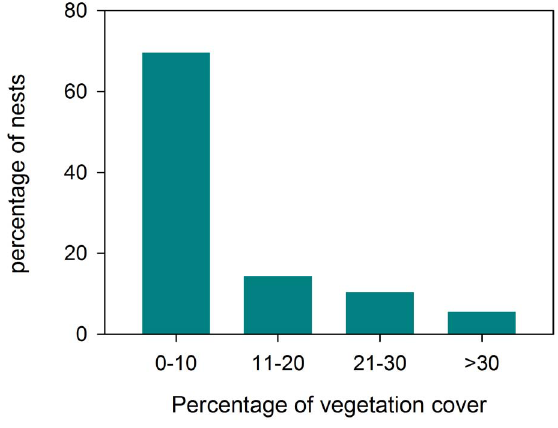
Figure 5. Frequency of Kentish plover nests in relation to vegetation cover.